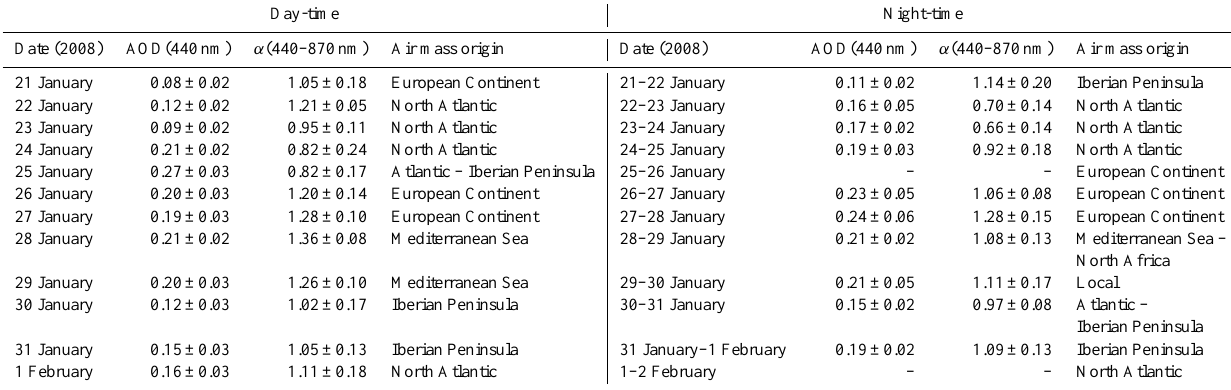
Table 5. Mean values of day- and night-time aerosol optical depth (AOD) and Angstr¨om exponent as well as the associated air-mass types that affected the study area for every day and night between 21 January and 1 February 2008. Air-masses backward-trajectories were computed by HYSPLIT model at